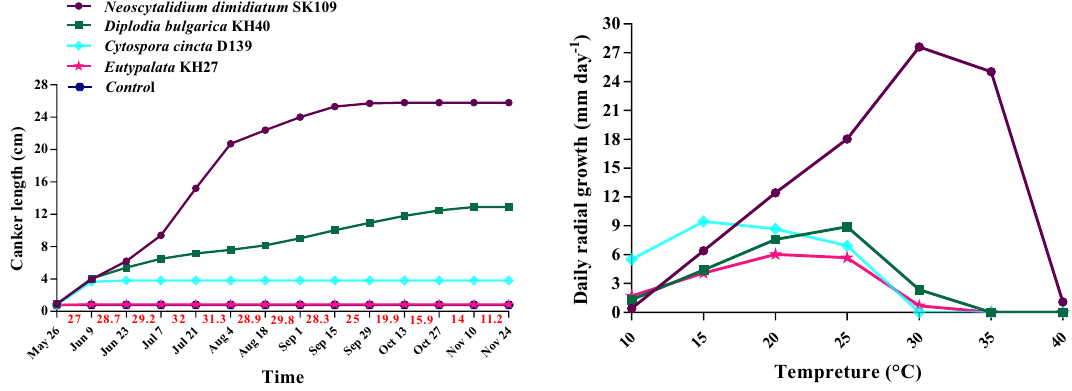
Figure 11. Canker progress curves of different species in the pathogenicity test on 2-year-old apple trees, Temperature is in red, and effect of temperature on daily radial growth of different species on potato dextrose agar. Average values (triplicate) are